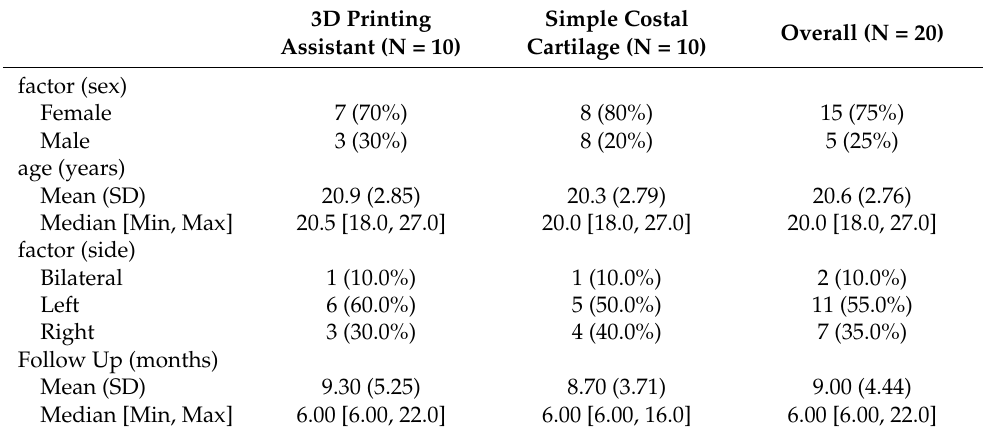
Table 1. The baseline information and the follow up time of the patients were recorded